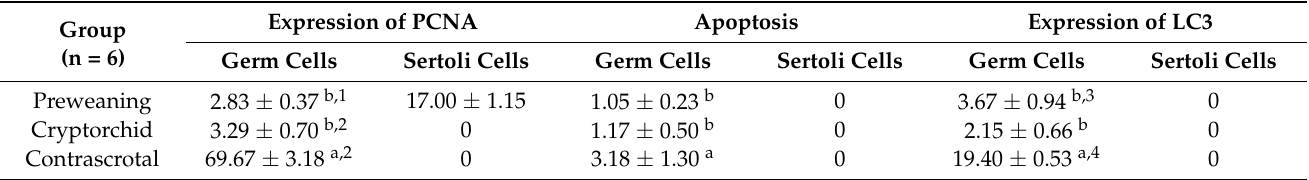
Figure 3. TUNEL detection of apoptotic nuclei in seminiferous tubules of boar testes. Apoptosis in preweaning, cryptorchid, and contrascrotal testes ( A – C ). Nuclei of apoptotic cells were stained dark brown. Sg, spermatogonia; Sp, spermatocyte; Sc, Sertoli cell. Bar = 25 µ m. Table 2. Expression of PCNA, LC3, and apoptosis in germ cells and Sertoli cells of preweaning, cryptorchid, and contrascrotal testes, respectively. The results represent mean ± SD.